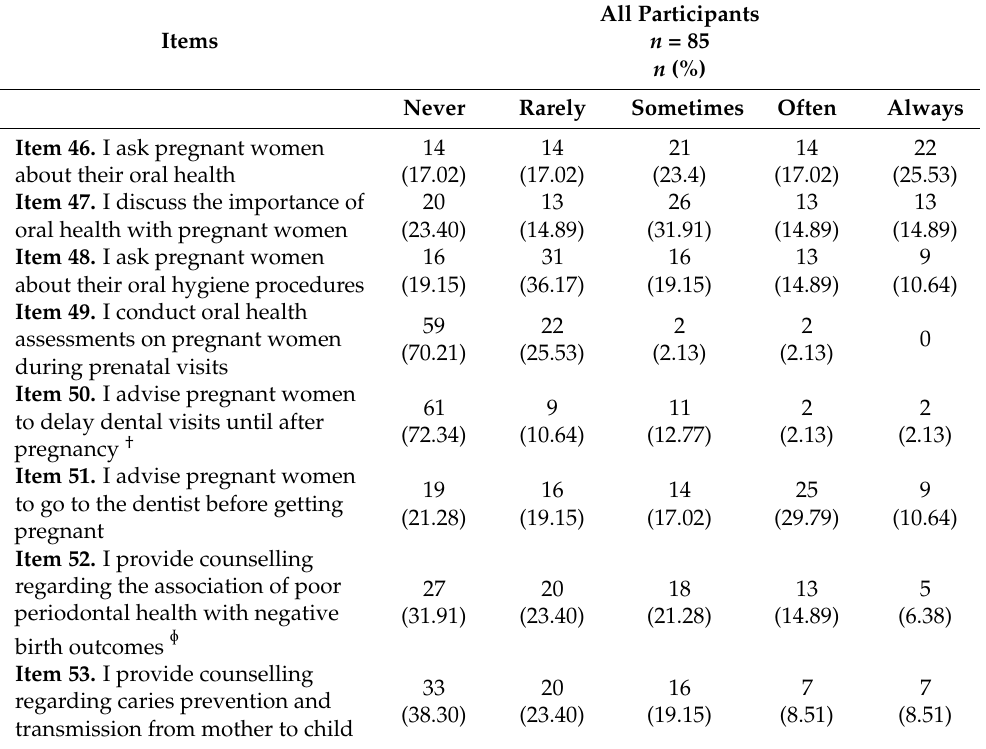
Table 2. Knowledge about oral health during pregnancy.